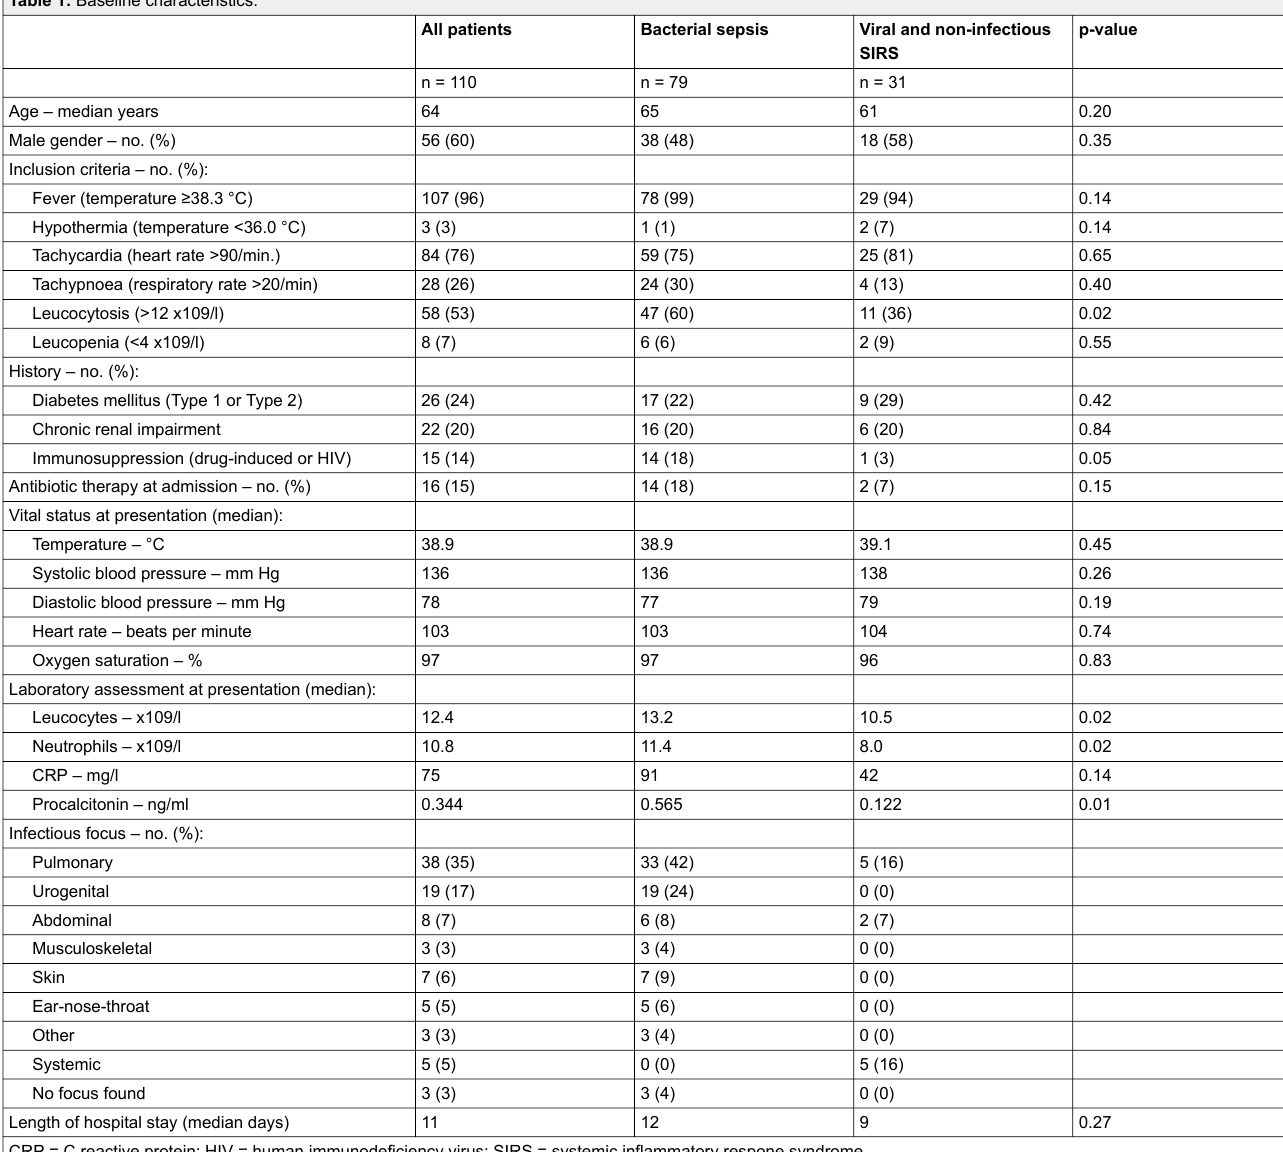
Table 1: Baseline characteristics.